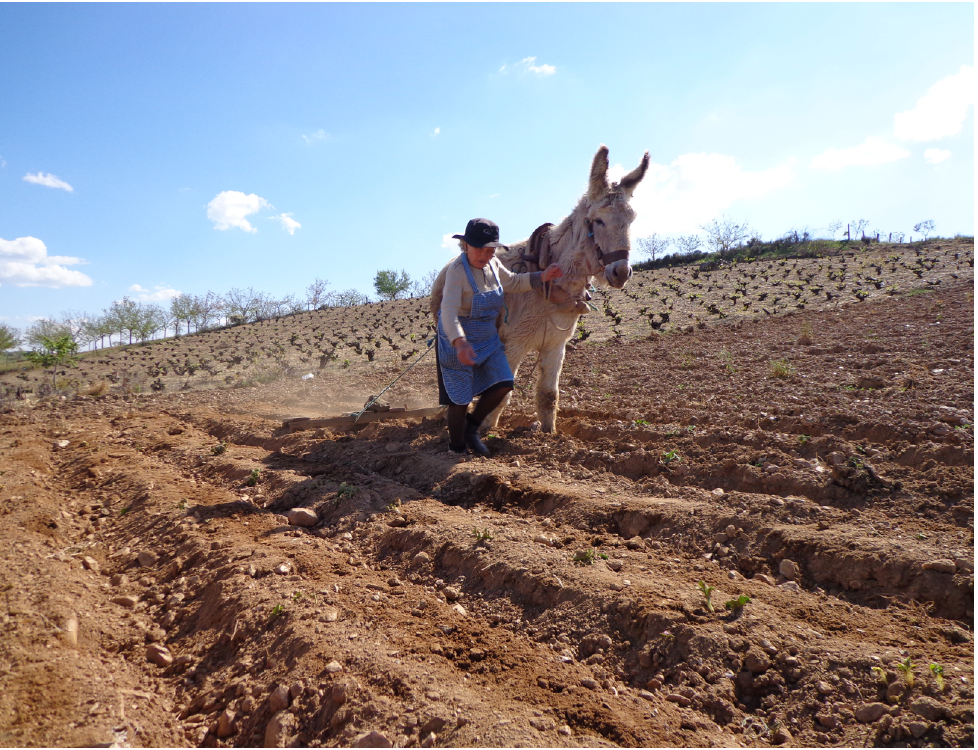
Figure 1: Traditional farmers in the mountain areas of the Northeast of Portugal still rely on working donkeys for draught purposes such as ploughing potatoes, as well as helping harvest grapes used for wine